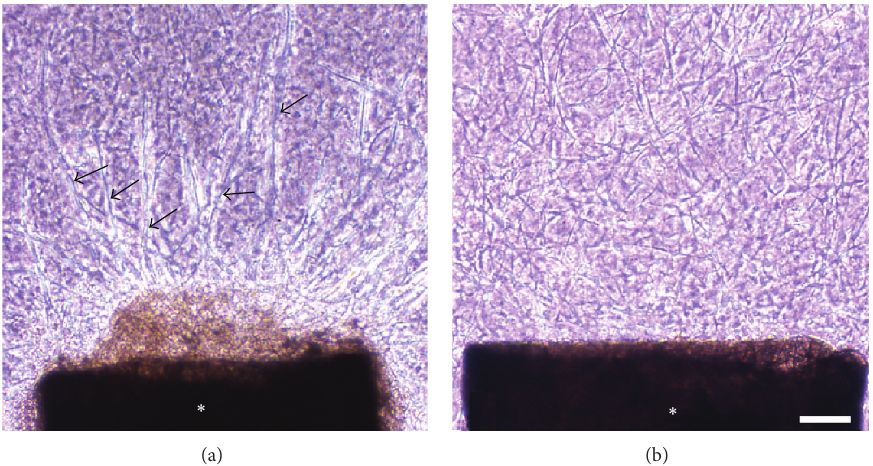
Figure 11: (a) A control culture from the rat aorta explant. Many capillary tubes (arrows) are present. (b) A deendothelialized rat aortic explant that has spindle-shaped cells migrating into collagen gels. However, capillary tube formation did not occur. Rat aortic explant ( ∗ ), Giemsa stain. Scale bar = 200 𝜇